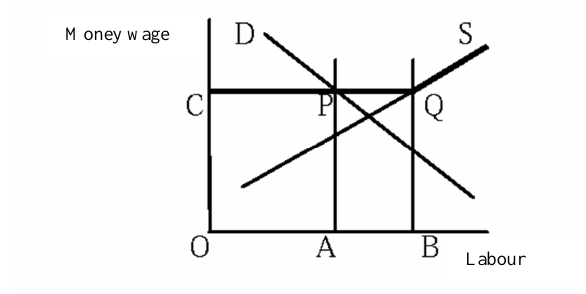
Figure 4. Lange’s representation of involuntary unemployment